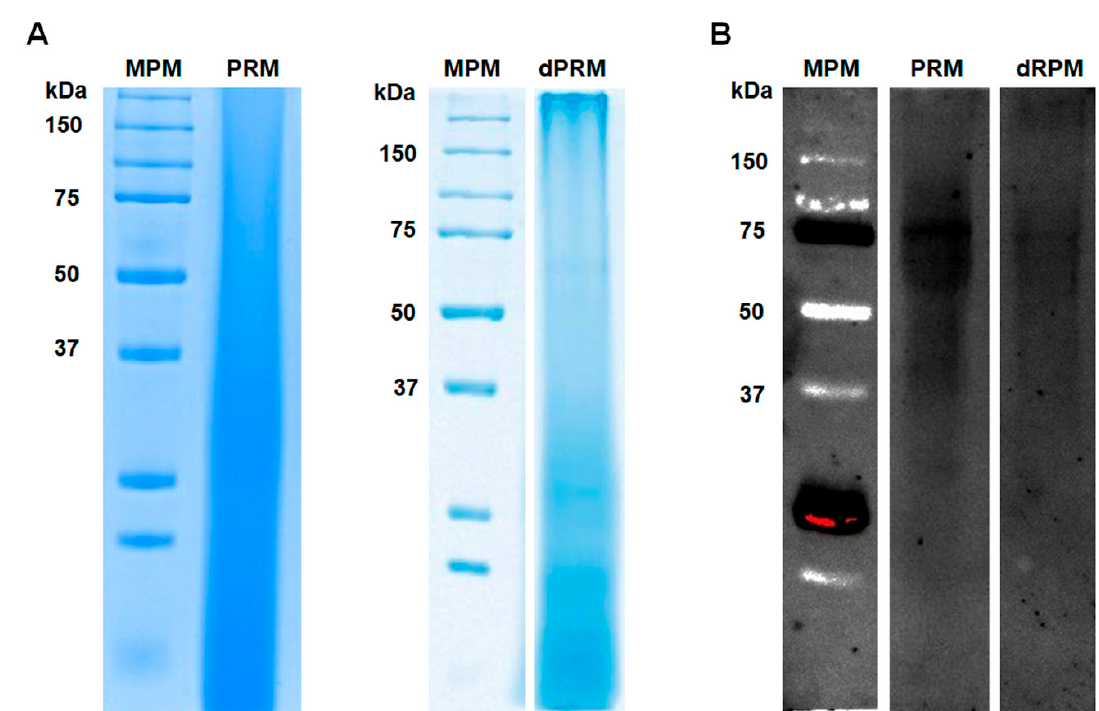
Figure 1. Peptidorhamnomannan analysis by denaturing electrophoresis and lectin blotting. Protein separation was carried out in 12% ( w / v ) polyacrylamide gels under denaturing conditions, and the separated material was either used for conventional protein staining with Commassie Blue ( A ) or was subjected to lectin blotting ( B ) using fluorenscein-conjugated concanavalin A. The membranes were inspected using a transilluminator with a wavelength set at 520 nm. MPM, molecular protein marker; PRM, peptidorhamnomannan. dPRM peptidorhamnomannan was treated with endoglycosidase H and β -elimination before electrophoresis.